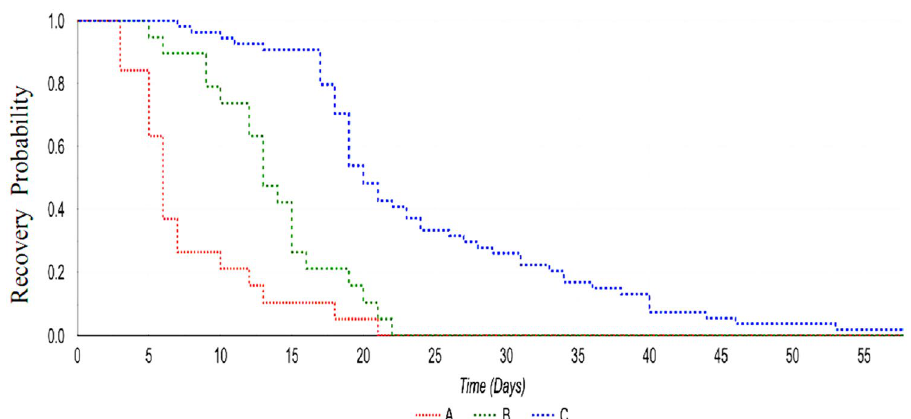
Figure 1. Kaplan–Meier curves of SARS CoV-2 infection clearance by SOF/VEL treatment (lines A,B) and spontaneously (line C; untreated control patients). Line (A): recovery time from infection starting from the first day of treatment with SOF/VEL. Lines (B,C) recovery time from infection starting from the first positive nasopharyngeal swab. Log-rang test: χ 2 = 307.02, p <